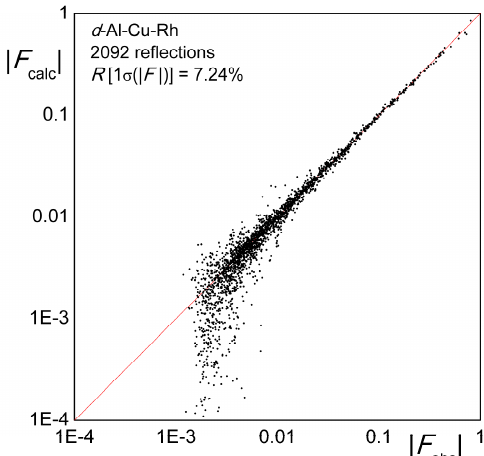
Figure 2. Calculated vs. measured amplitudes of 2092 unique reflections normalized to the strongest one. A typical bias is observed for small amplitudes <0.01.